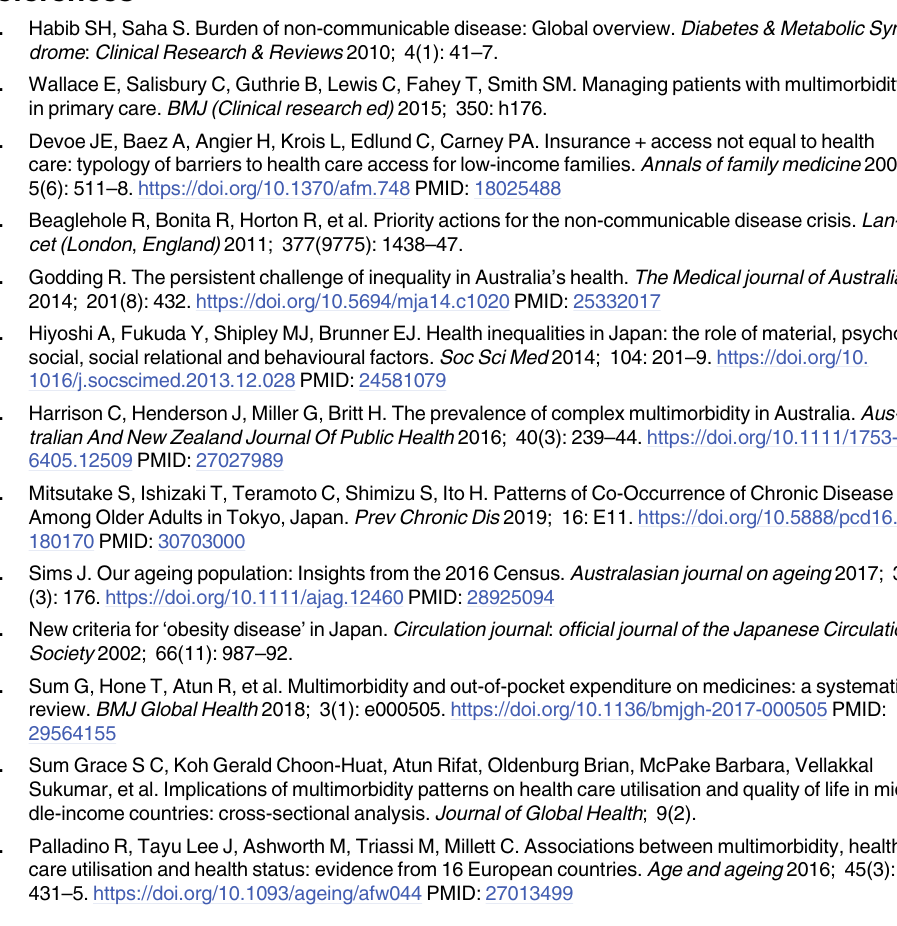
S4 Fig. Prevalence of individual non-communicable diseases (Japan).